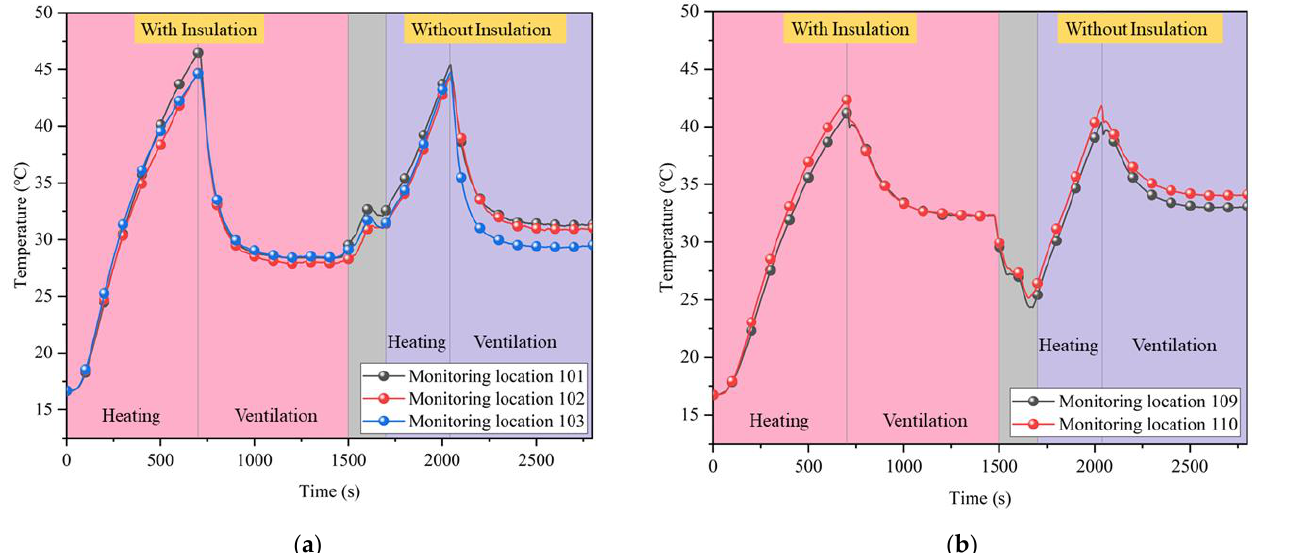
Figure 7. Temperature variation in the tunnel under coupled cooling test: ( a ) Inside the insulation area; ( b ) Outside the insulation area.